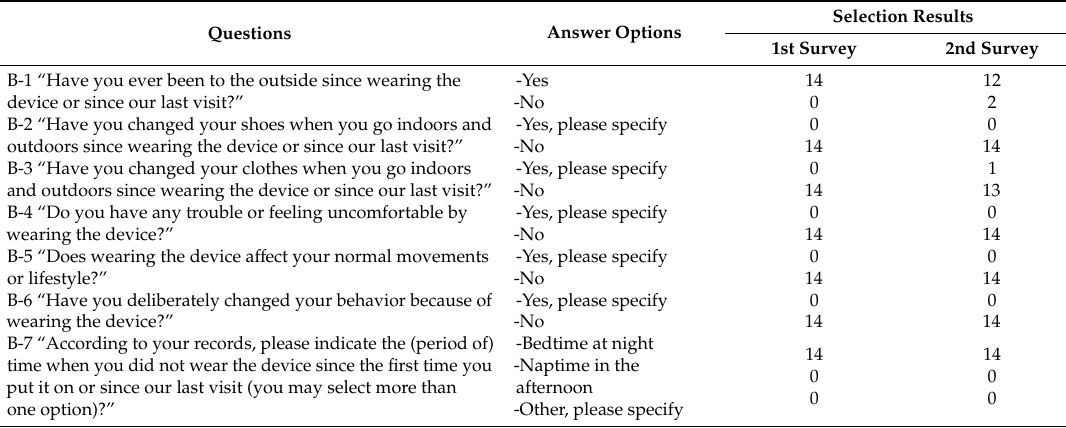
Table 3. Responses to questions in the “personal thermal exposure experience” part (N =